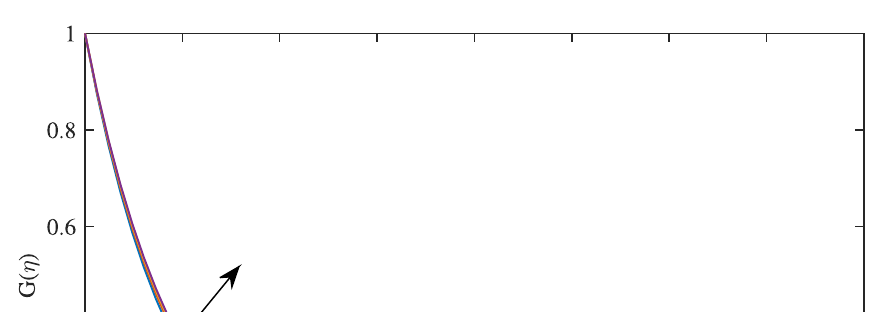
Figure 15. Effects of critical shear rate β on radial velocity, when c 6.2 . and Pr =